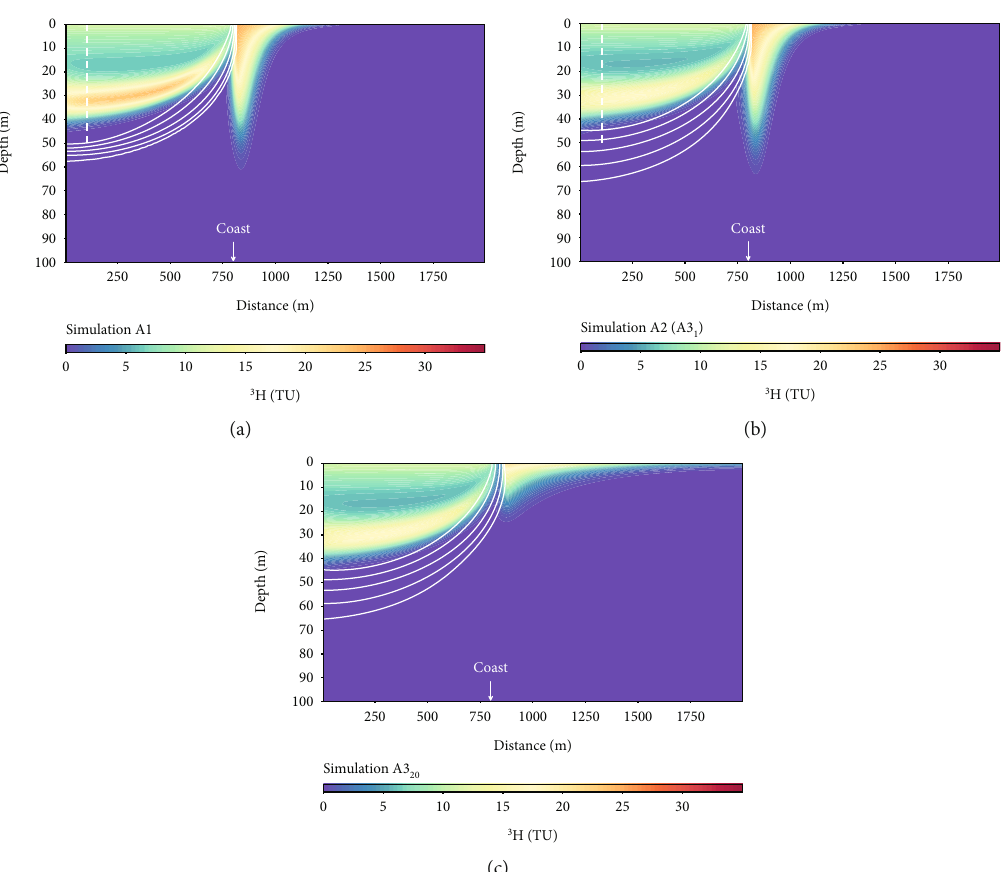
), and (c) A3 . The dashed 1 20